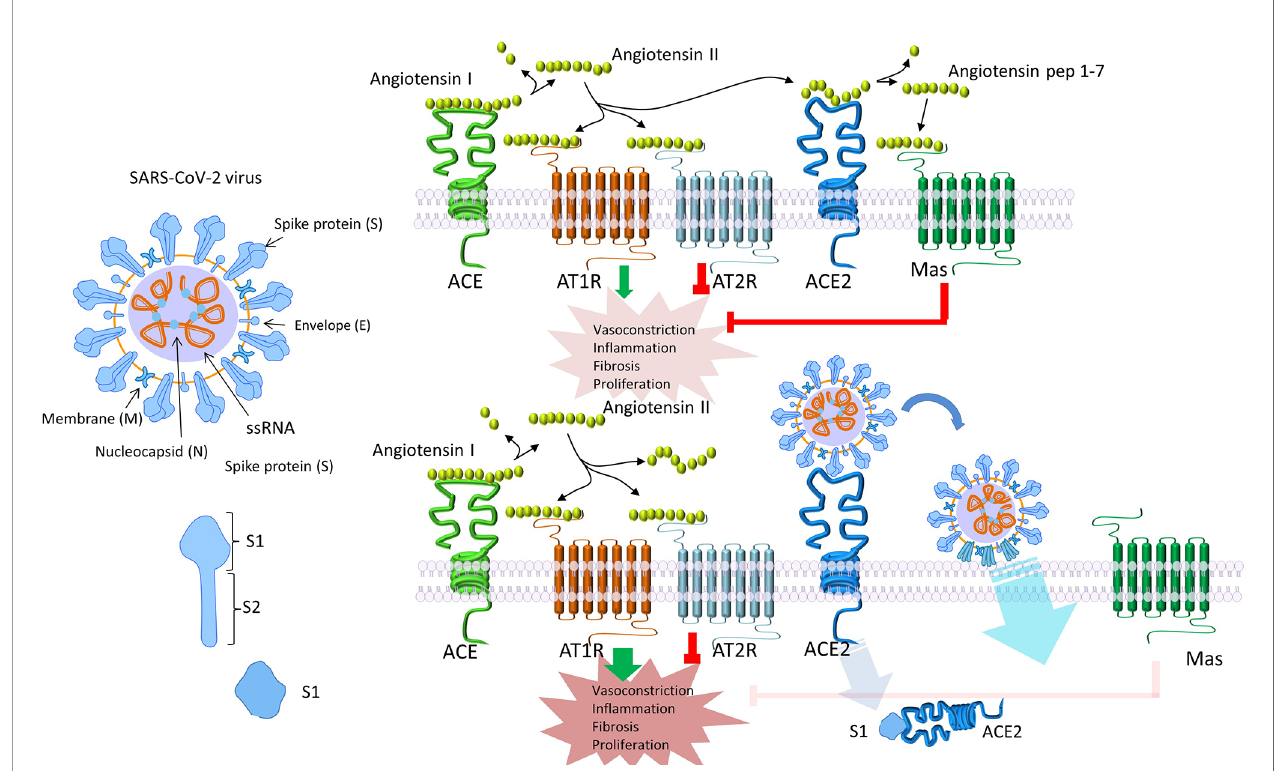
FIGURE 2 | SARS-CoV-2 endocytosis alters angiotensin II signaling. Following endocytosis of SARS-CoV-2 together with its receptor ACE2, the number of available ACE2 molecules on the cell membrane is decreased (20). As a result, circulating angiotensin II is not degraded to angiotensin 1-7 . Angiotensin II signals mainly through AT1, while angiotensin 1-7 through AT2 and Mas receptors. Signaling through AT1, increases vasoconstriction and interstitial fi brosis, enhances in fl ammation by macrophage activation and, eventually, the production of in fl ammatory cytokines, induces endothelial dysfunction, and increases pulmonary permeability leading to pulmonary edema and ARDS (23). Reduced expression of ACE2 can indirectly activate the kinin-kallikrein system, leading to increased vascular permeability (24). Simultaneously, downregulation of ACE2 has been connected to myocardial hypertrophy and dysfunction, obesity-associated hypertension and increased oxidative stress (20, 25, 26). Interestingly, in many conditions which serve as high risk factors for COVID-19, like increased age, male gender, obesity, diabetes mellitus, arterial hypertension, and heart insuf fi ciency, ACE2 is downregulated or de fi cient (20, 27 – 29). The subsequent, already increased AT1 signaling, could, at least partially, explain the increased risk and the worse clinical progression of COVID-19 in these patients (20). To the contrary, signaling through AT2 or Mas receptors, has the opposite effects and therefore seems to confer a protection against angiotensin II – AT1 signaling (20, 30). ACE2, angiotensin-converting enzyme 2; AT, angiotensin II